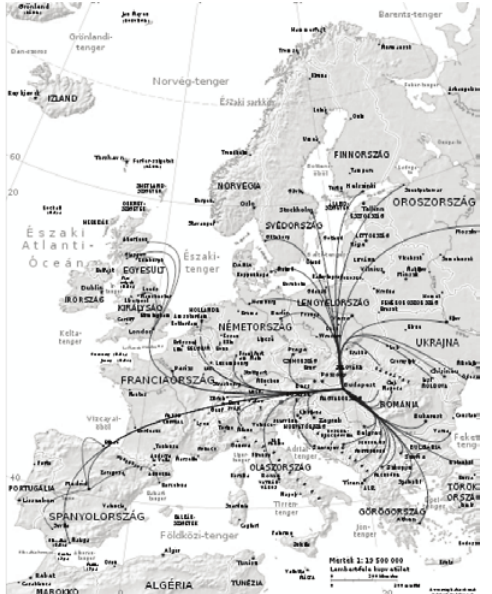
fig. 1. European destinations of MALEV (Source: MALEV)